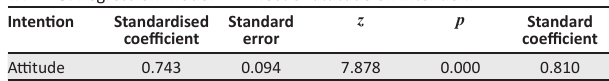
TABLE 5: Regression Model 2 – Effect of attitude on